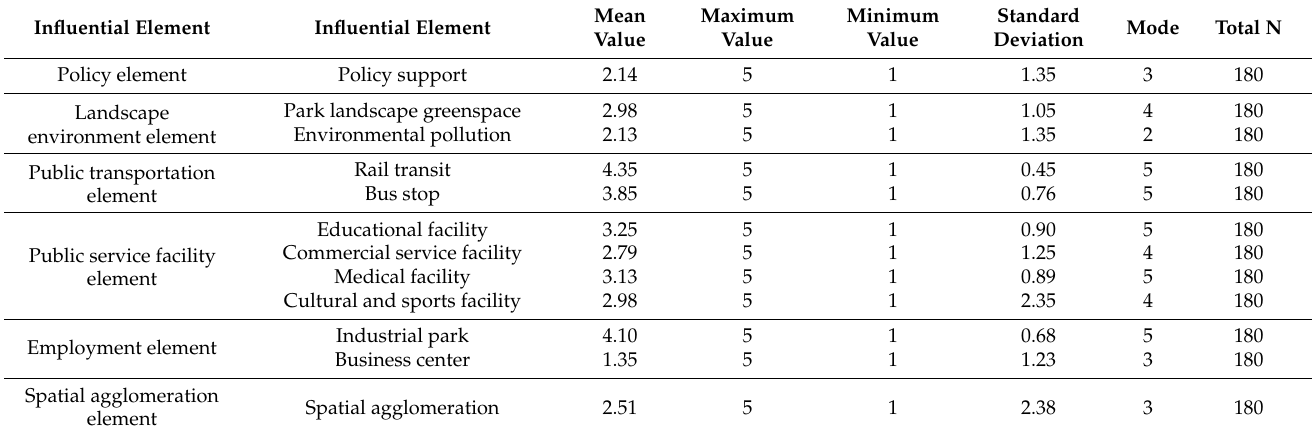
Table 5. Descriptive analysis and statistical result of influential elements.